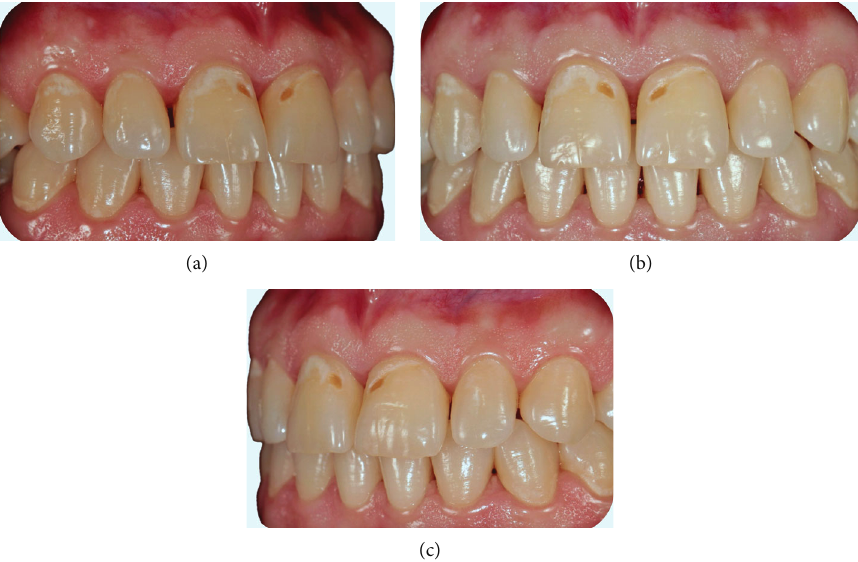
Figure 1: Initial views of caries lesions. (a) Right angle, (b) Front angle, (c) Left